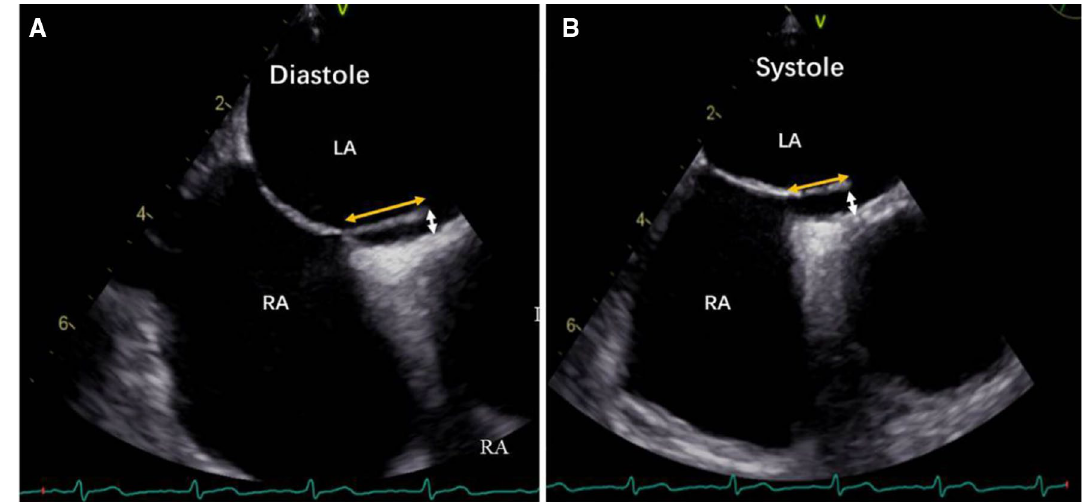
Fig. 2 PFO size and tunnel length. The PFO size (white arrow) was measured via the maximum separation in the ventricular systole and dias- tole, the length of the PFO tunnel (yellow arrow) was measured via the maximum overlap in the ventricular systole and diastole